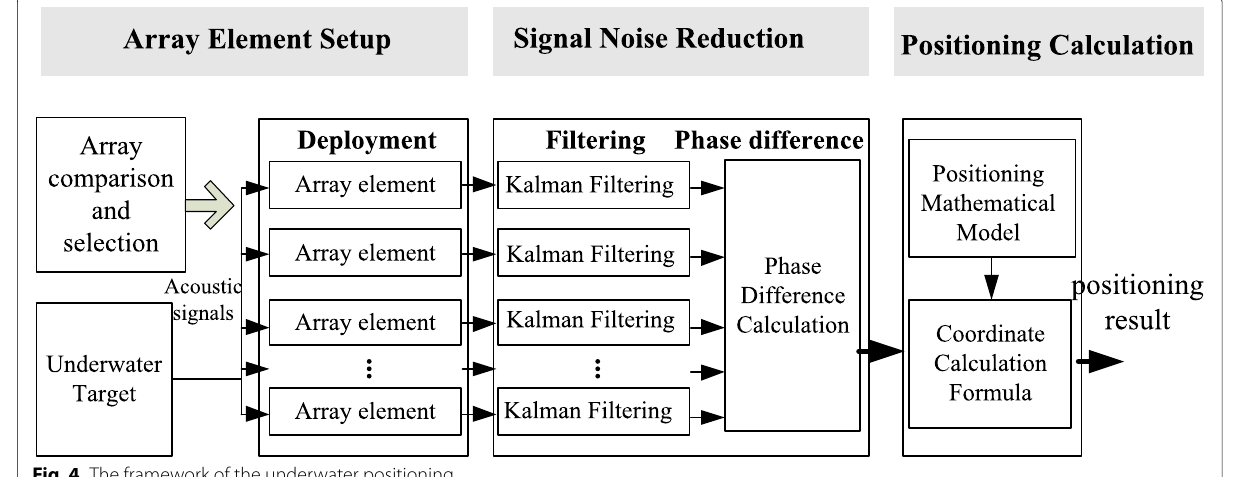
Fig. 4 The framework of the underwater positioning